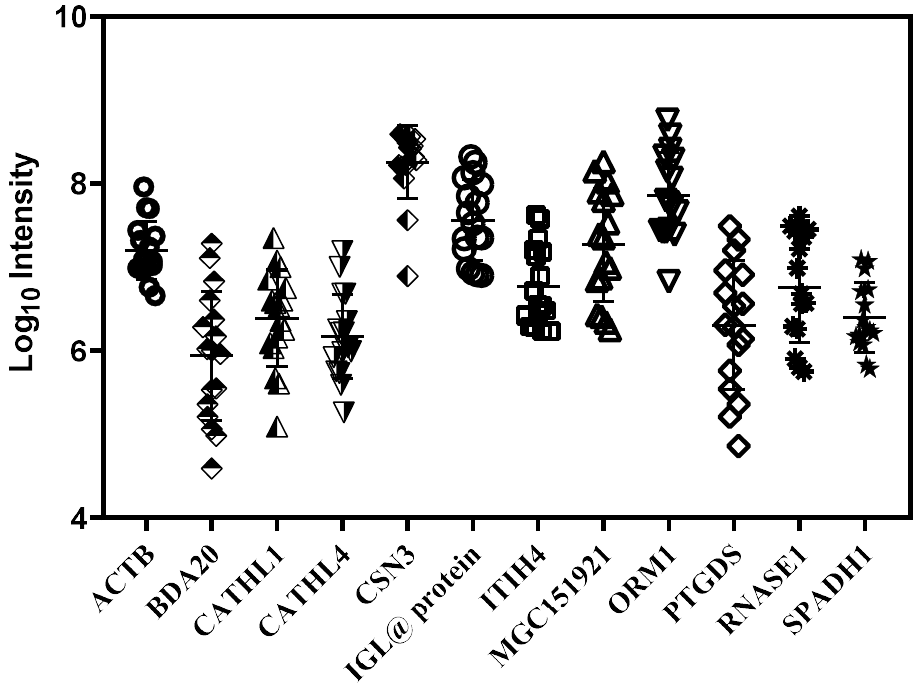
Figure 5. Relative abundance distribution of 12 most highly variable proteins among 17 individual cows. ACTB: Actin, cytoplasmic 1; BDA20: Allergen Bos d 2; CATHL1: Cathelicidin-1;